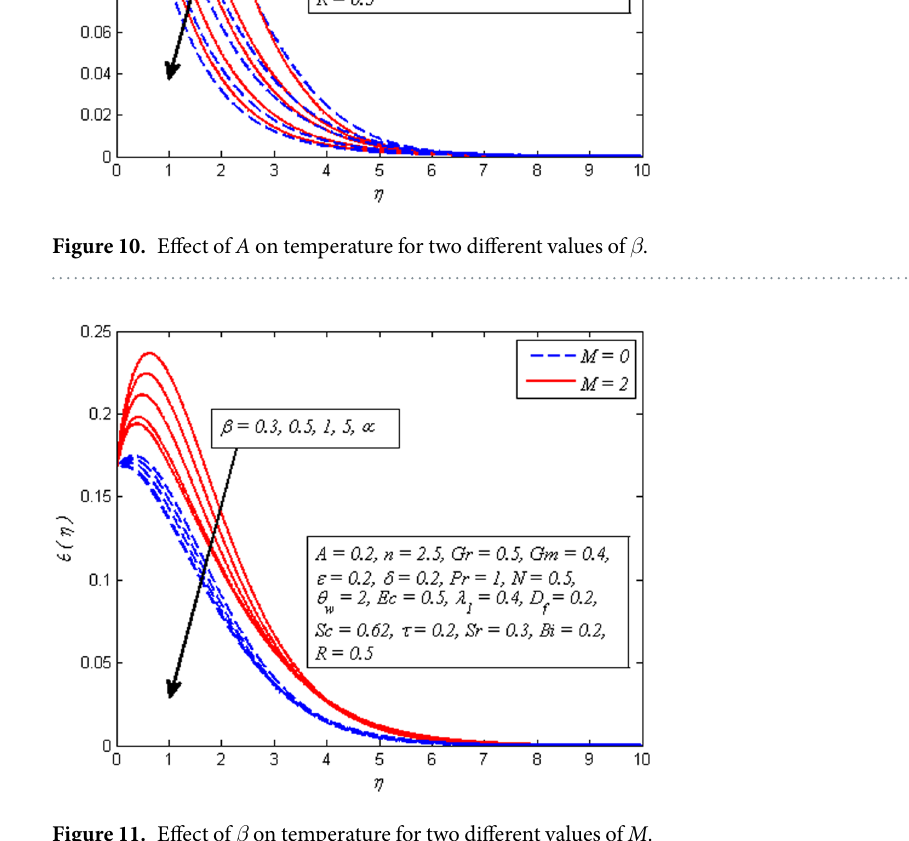
Figure 11. Effect of β on temperature for two different values of M .